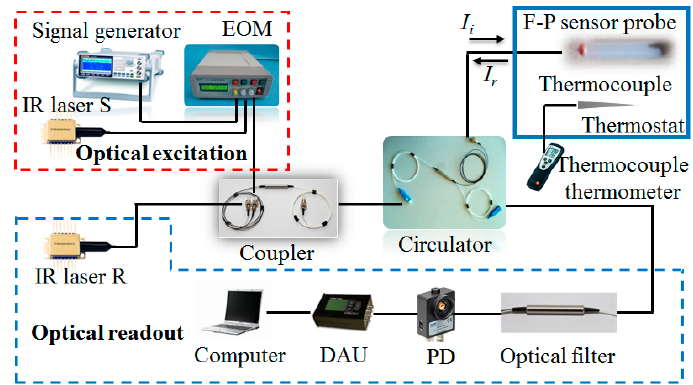
Figure 4. Schematic illustration of optical fiber F ‐ P excitation and detection.